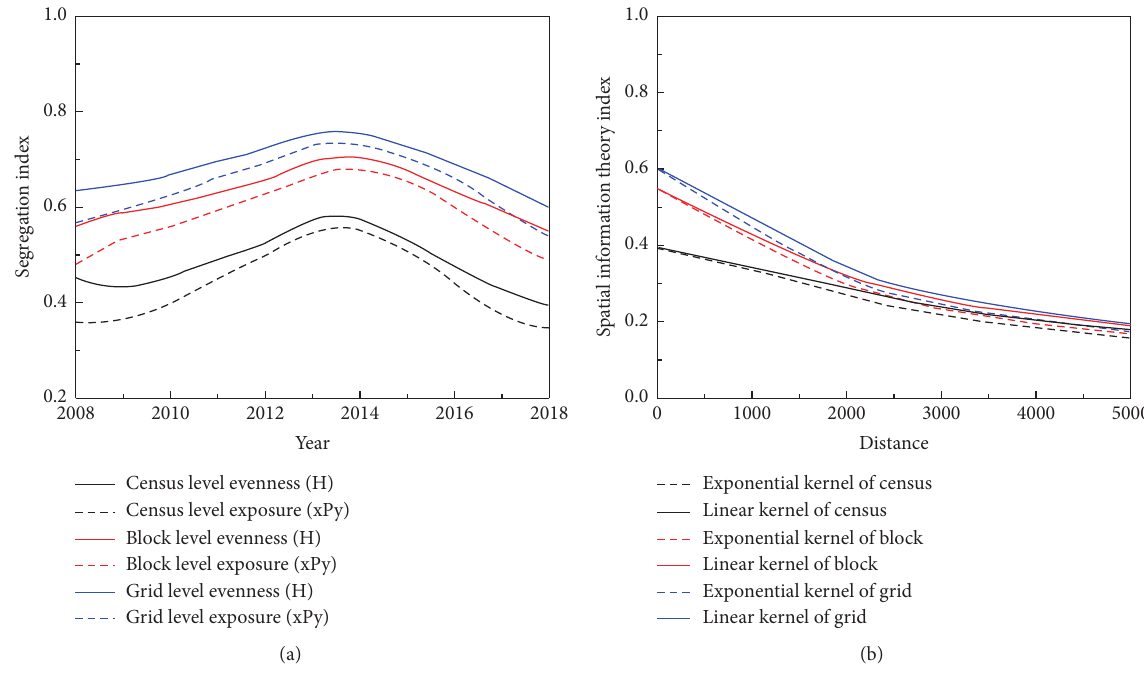
Figure 6: Residential heterogeneity of different scales in